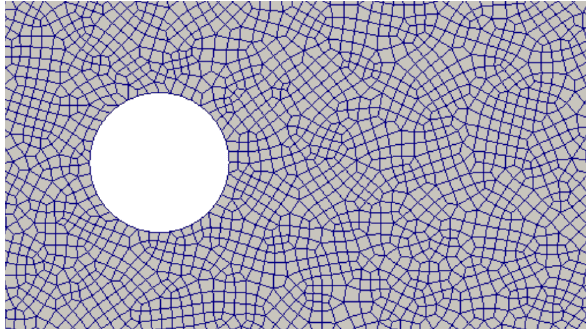
Figure 1. Part of the mesh under